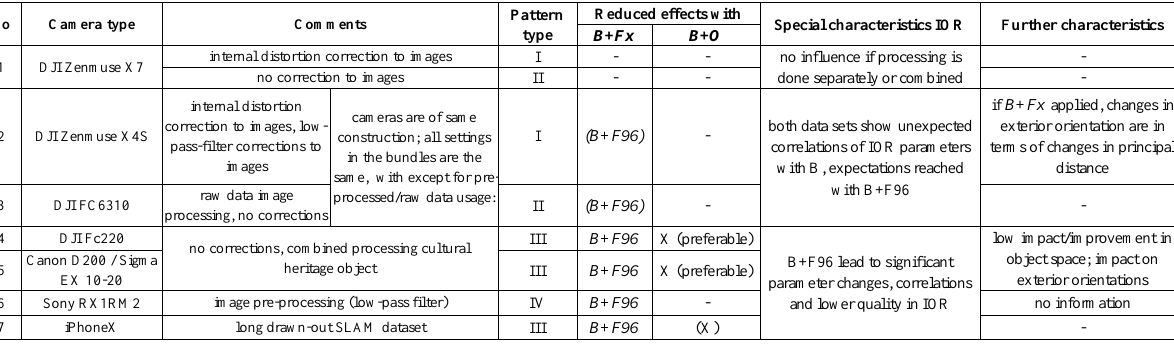
Table 2. Overview on conclusions with respect to the data